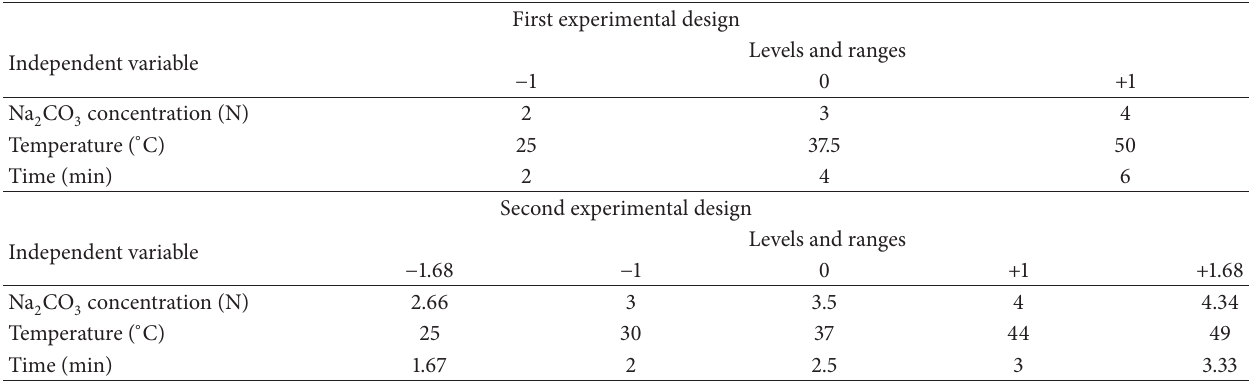
Table 1: Levels and ranges of the independent variables (Na experimental designs.